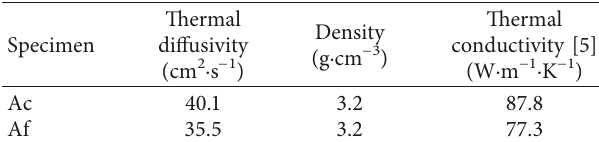
Table 3: Thermal diffusivity, density, and thermal conductivity for